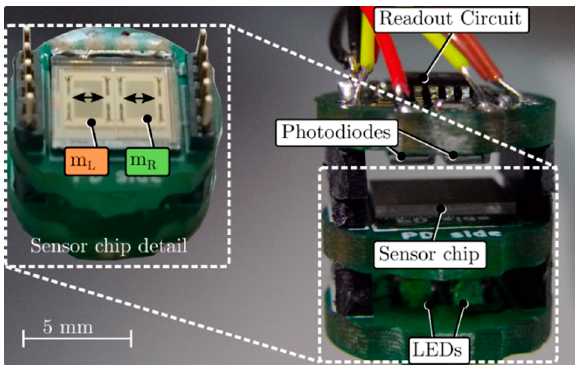
Figure 1. Assembled stack including a readout circuit, photodiodes (PD), sensor chip, and LEDs. The light flux is modulated by relative in-plane movements of the Si masses m L and m R , actuated by Lorentz forces, and the stationary glass frame. The fixed glass mask features vapor deposited Cr arrays of apertures. Hence, the PDs receive the modulated light passing through the masses and glass mask. The on-board electronics include LEDs driver and two transimpedance amplifiers (TIA) to convert the signals detected by the PD into an amplified output voltage. A magnetic field perpendicular to the current carrying masses introduces a force which induces a in-plane oscillation. When both masses deflect in the same direction, one mass suppresses light by closing the apertures whereas the other mass opens the